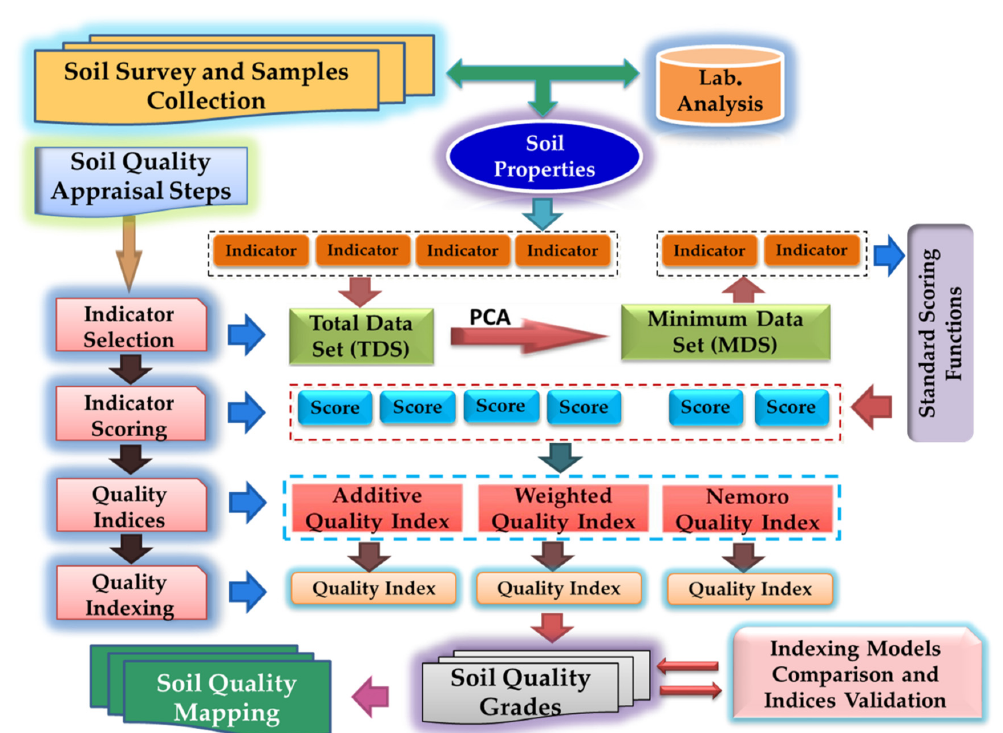
Figure 3. Methodology flowchart for soil quality assessment.